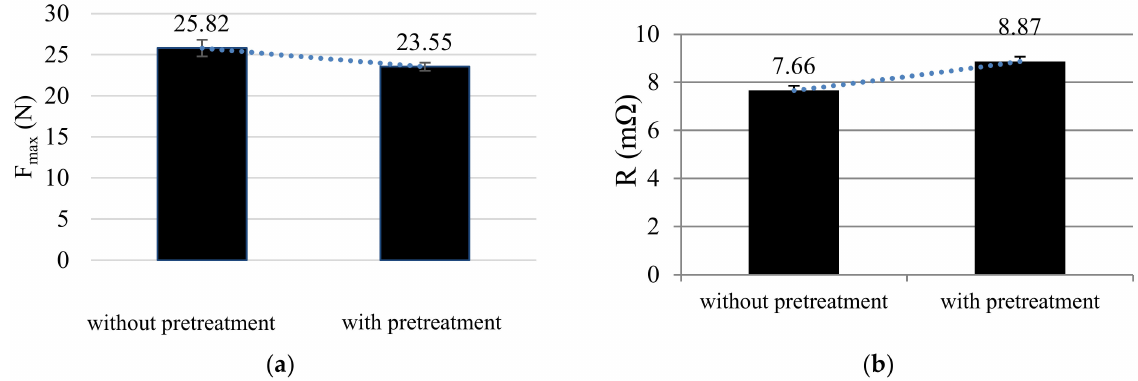
Figure 10. ( a ) With the reduced tensile strength during the peeling test after pretreatment; ( b ) with the increased contact resistance after pretreatment with